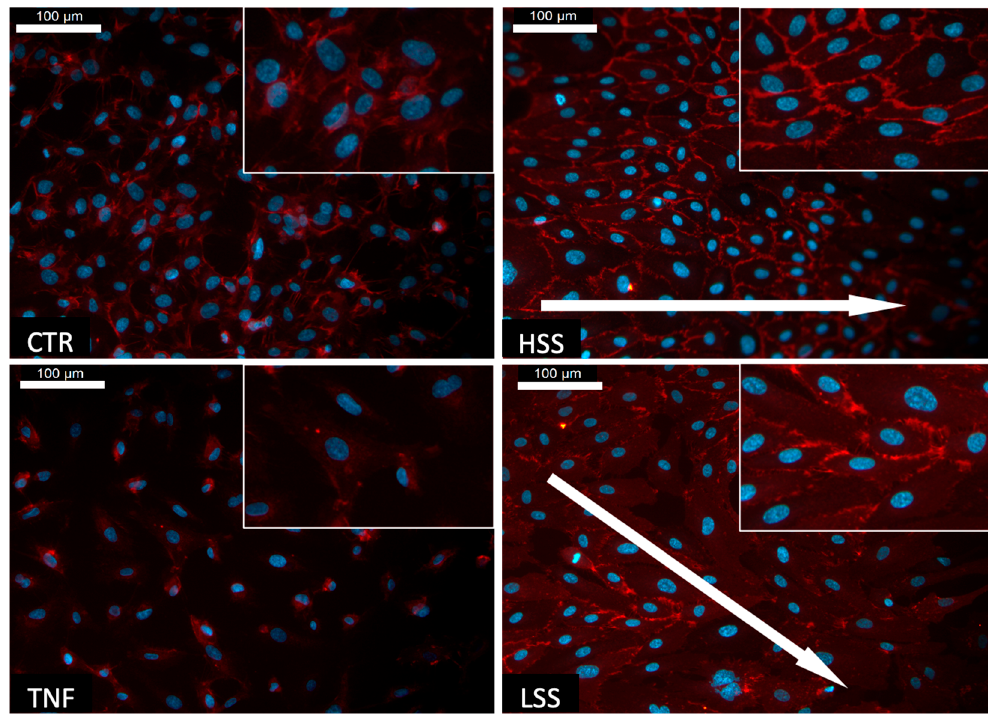
Figure 2. PECAM-1 (CD31) staining in HUVECs cultured in static and dynamic conditions. Repre- sented in blue are the cells’ nuclei, while in red are PECAM-1 proteins. White arrow indicates the flow direction. Scalebar: 100 µ